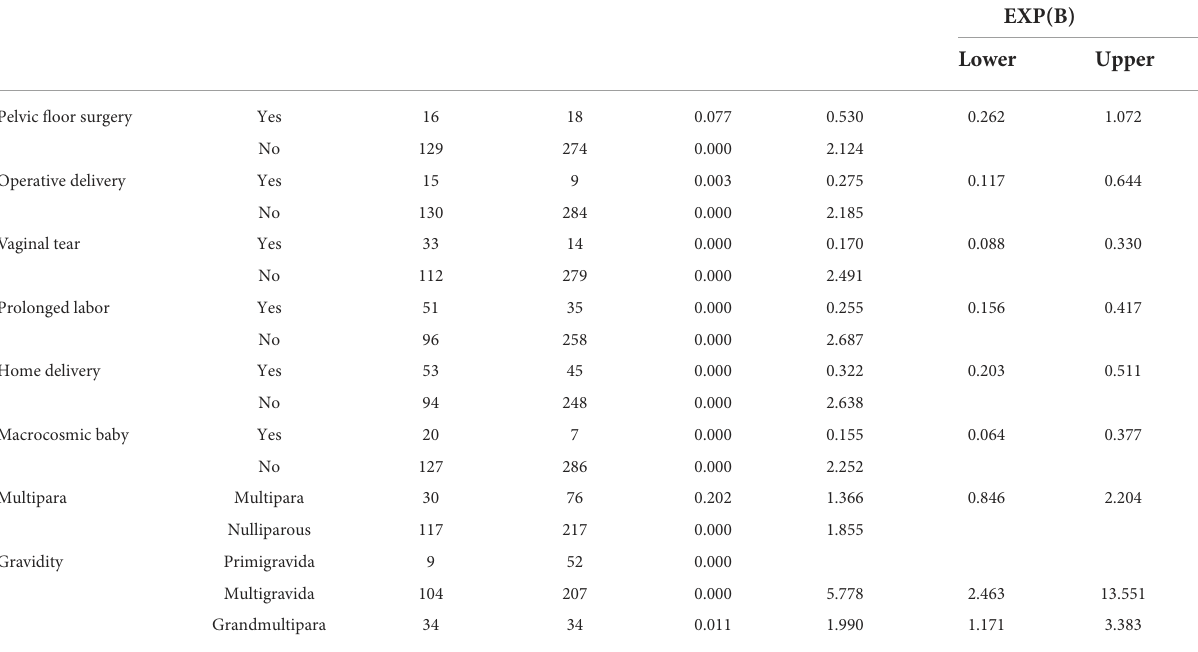
EXP(B) Lower Upper